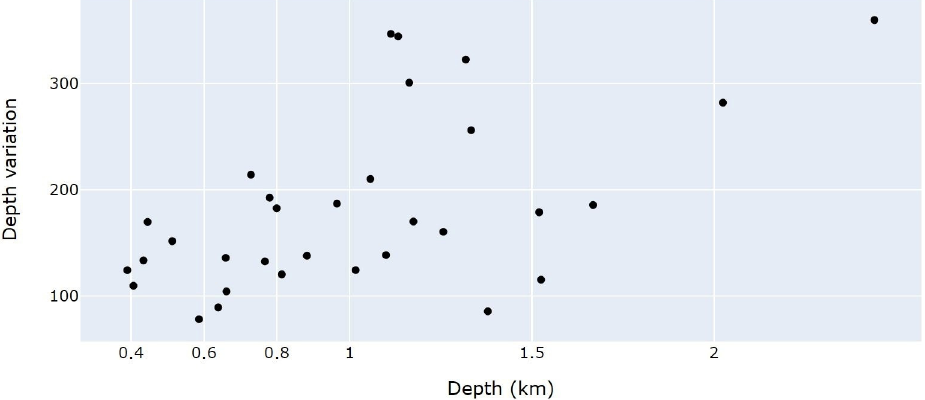
Figure 13. Depth versus depth variation. Data plotted is strictly for craters with approximately 10 km of diameter.